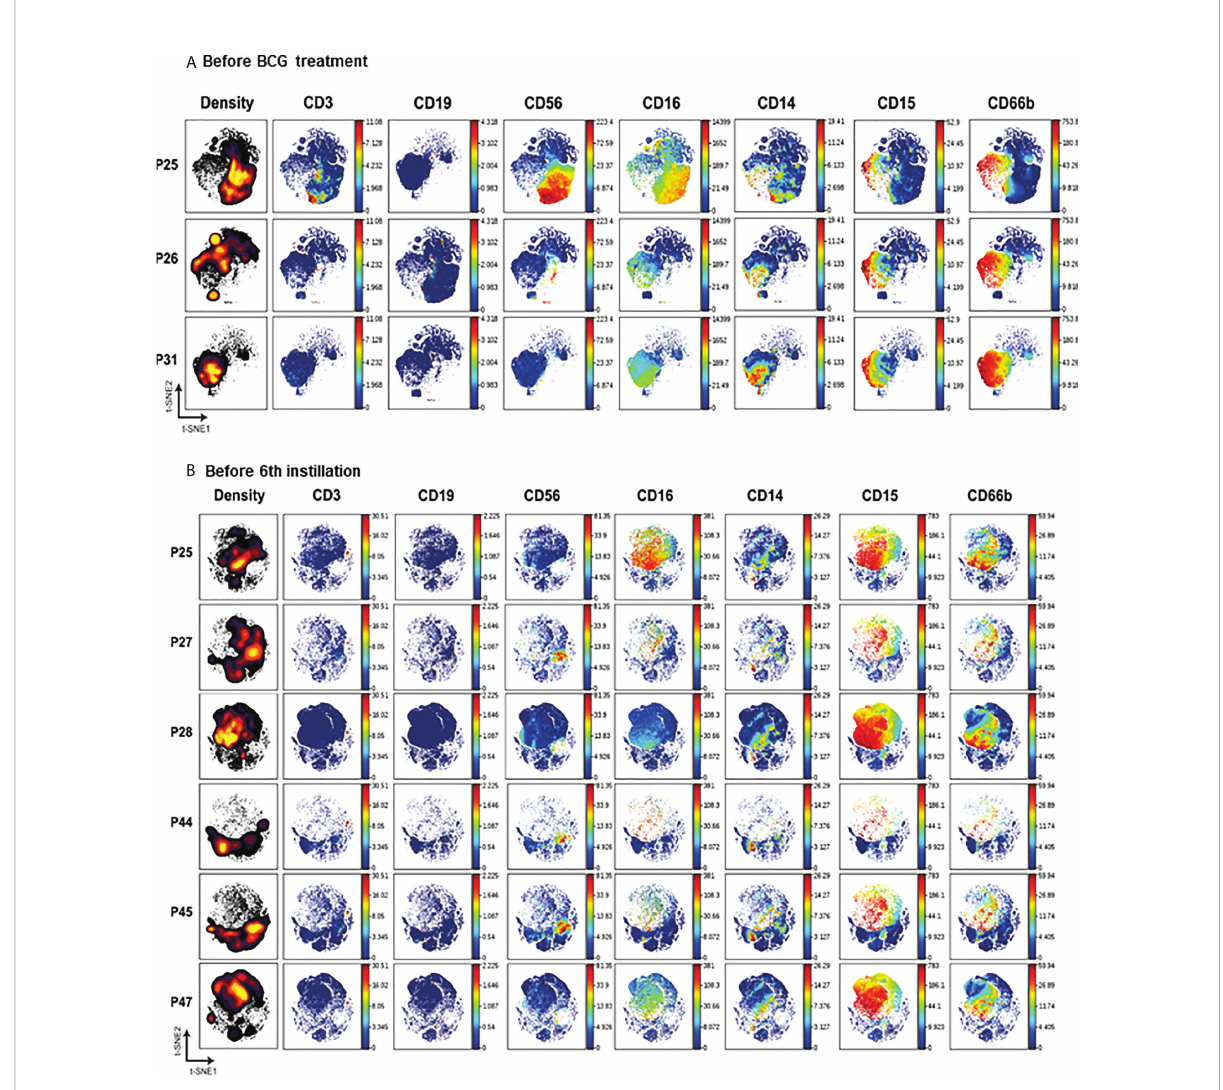
FIGURE 3 Mass cytometry analysis of cells from patients at the same stage of treatment. viSNE analysis was performed grouping patients at the same stage of treatment: either before starting BCG treatment (A) or 7 days after receiving the 5 th instillation (B) . The left column represents the density plots while the rest of the plots correspond to the main PBMC population